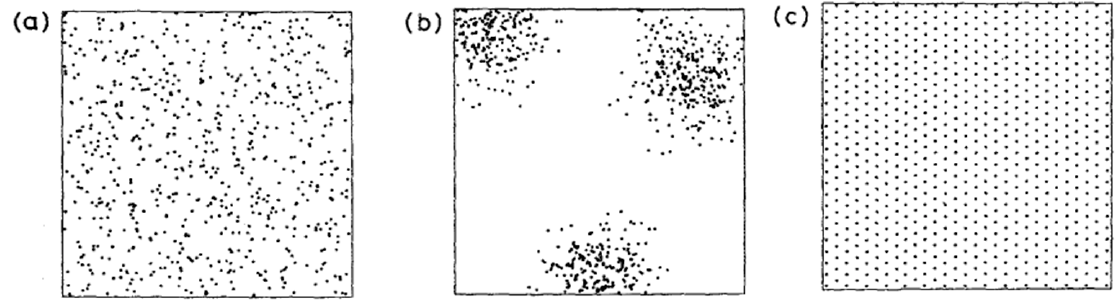
Figure 16. Three typical point placement patterns: ( a ) Poisson, ( b ) cluster, and ( c ) regular types. Reprinted from Ref. [71] (© 1989 AIP Publishing).